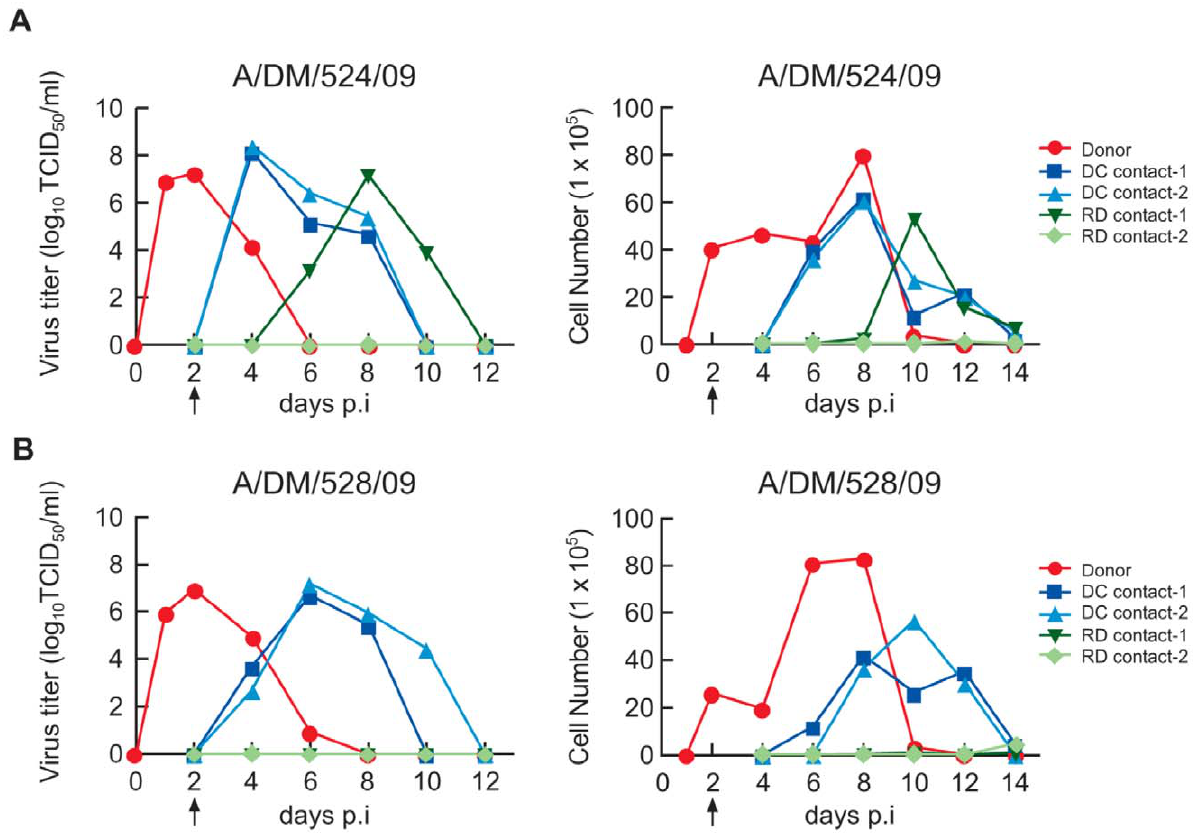
Figure 2. Transmissibility of the two H1N1/2009 influenza viruses among ferrets. The virus titer (A, B left panel) and total number of inflammatory cells (A, B right panel) in the nasal wash samples from each donor ferret, direct-contact (DC contact) ferret, and respiratory droplet- contact (RD contact ) ferret. The arrow indicates the first day of exposure of contact ferrets.